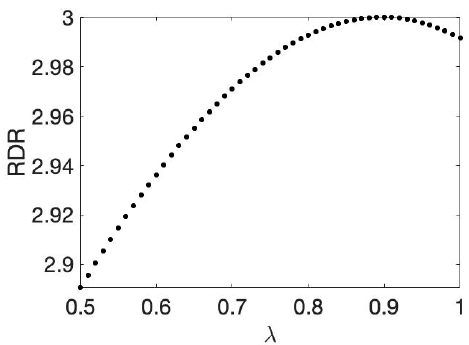
Figure 16. RDR vs. 𝜆 for a higher-order process.